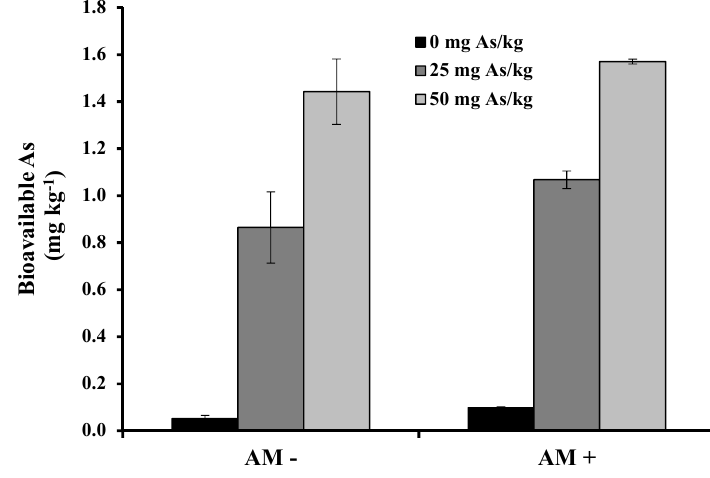
Figure 6. Concentration of bioavailable As in the substrate, according to the